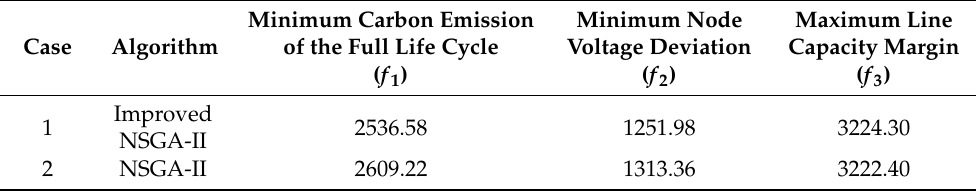
Table 2. Comparison of objective function values between different